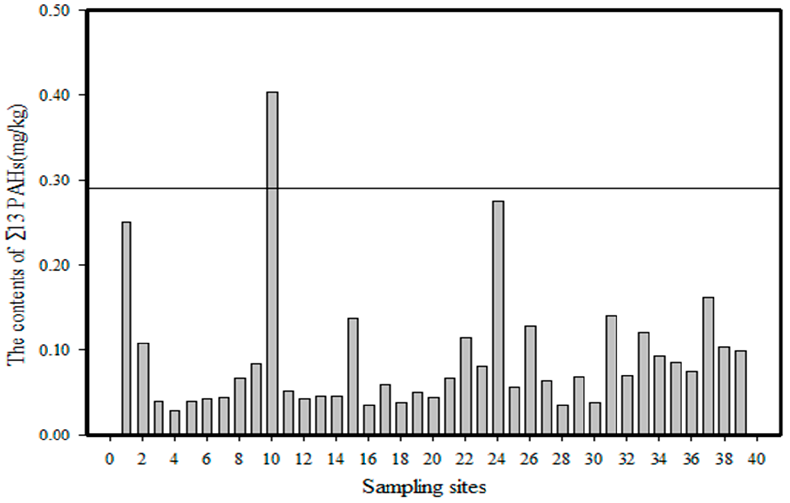
Figure 11. Ecological risk assessment based on organic carbon normalization method of PAHs in soils of the Momoge Wetland.